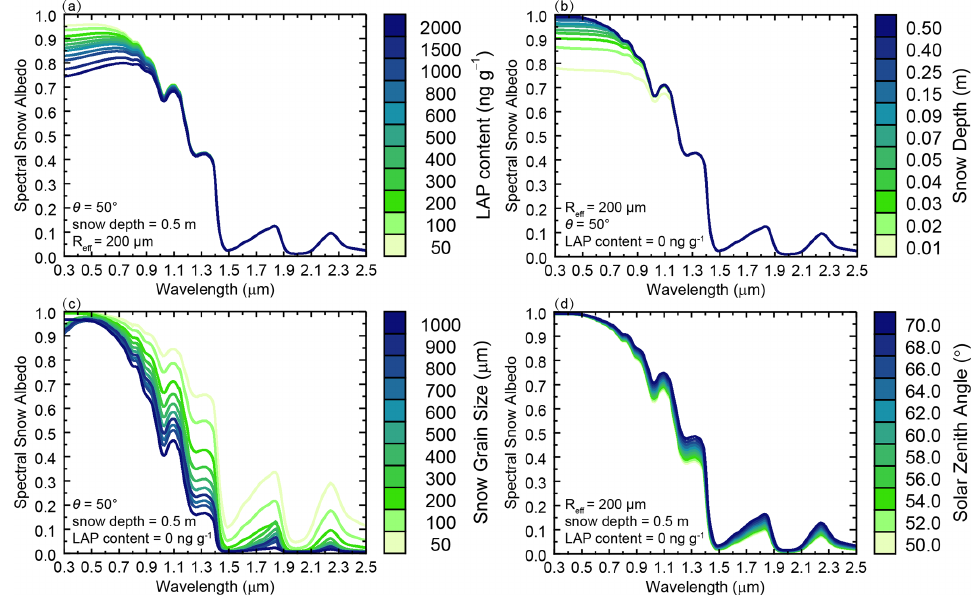
Figure 1. Variations in spectral snow albedo due to (a) LAP content (ngg − 1 ), (b) snow depth (m), (c) snow grain size (µm), and (d) solar zenith angle ( ◦ ) while the other three parameters are kept